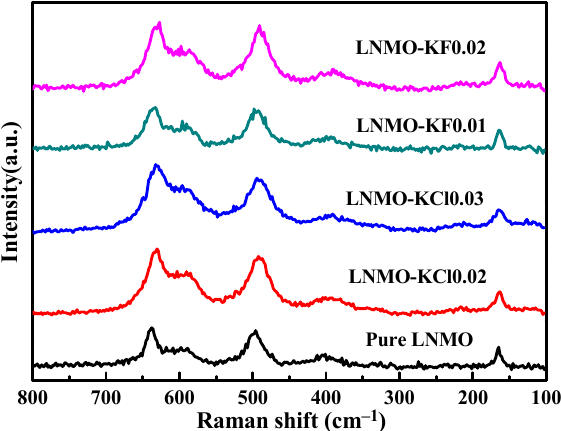
Figure 2. Raman spectra of all the samples.